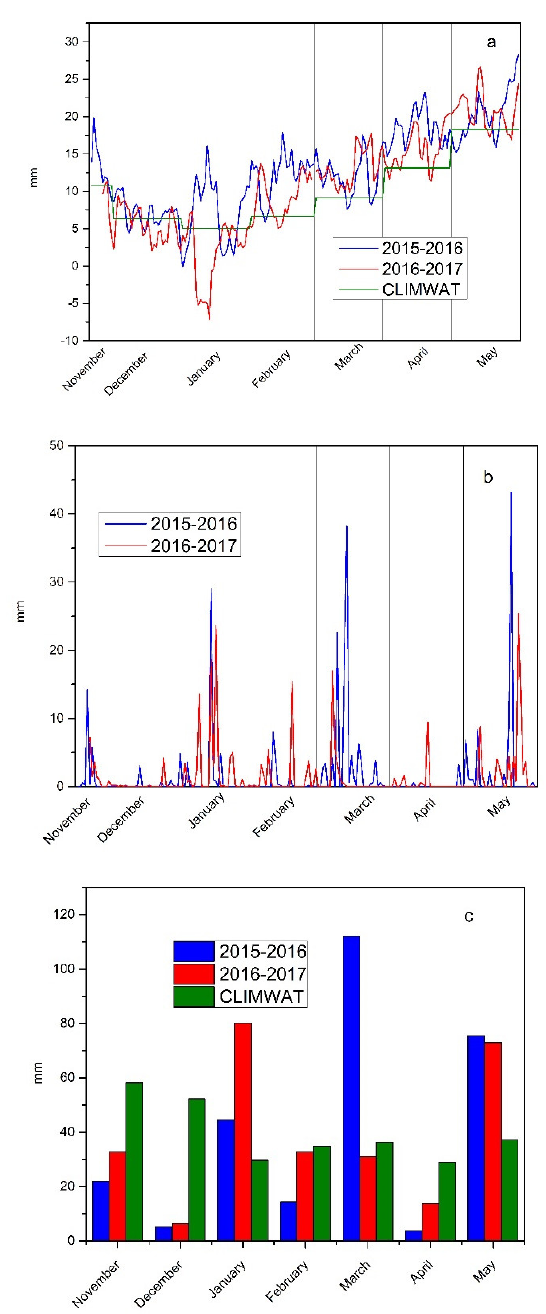
Figure 4. ( a ) Mean temperature of 2015–2016 and 2016–2017 growing seasons compared to 30